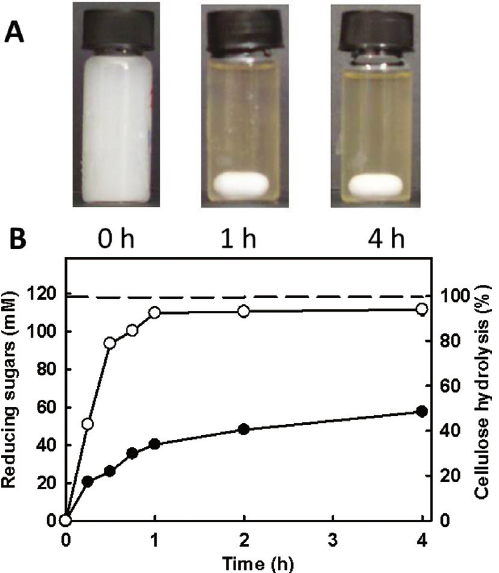
Figure 2 (A) Time course profiles of the hydrolysis of cellulose and reducing sugar production catalyzed by the combined action of cellulase (Celluclast 1.5L, 4.6 mg/ml of reaction medium) and cellobiase (Novozyme 188, 1.4 mg/ml of reaction medium), using microcrystalline cellulose (●) and regenerated cellulose (○) as substrate in citrate buffer pH 4.8 at 50 ° C. (B) Pictures of the reaction medium at different reaction times.